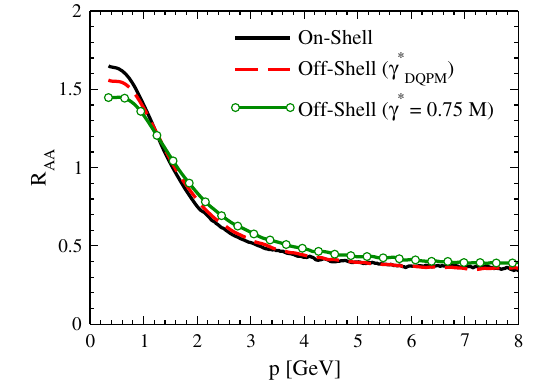
Fig. 14 Nuclear modification factor, R AA as function of charm momentum p . Solid lines refers to the case of on-shell calculations. The red dashed line refer to off-shell calculation with scattering matrix scaled with the energy density while the green open circles refer to the same calculation but with larger width fixed to γ ∗